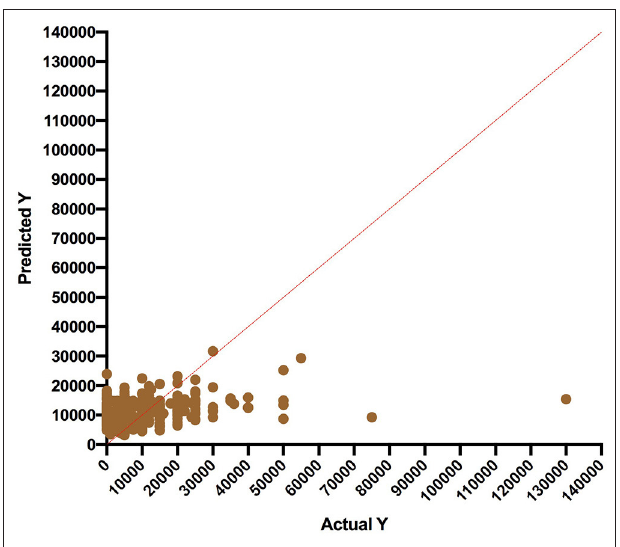
FIGURE 1 | Actual vs. predicted WTP using a multiple linear regresion.